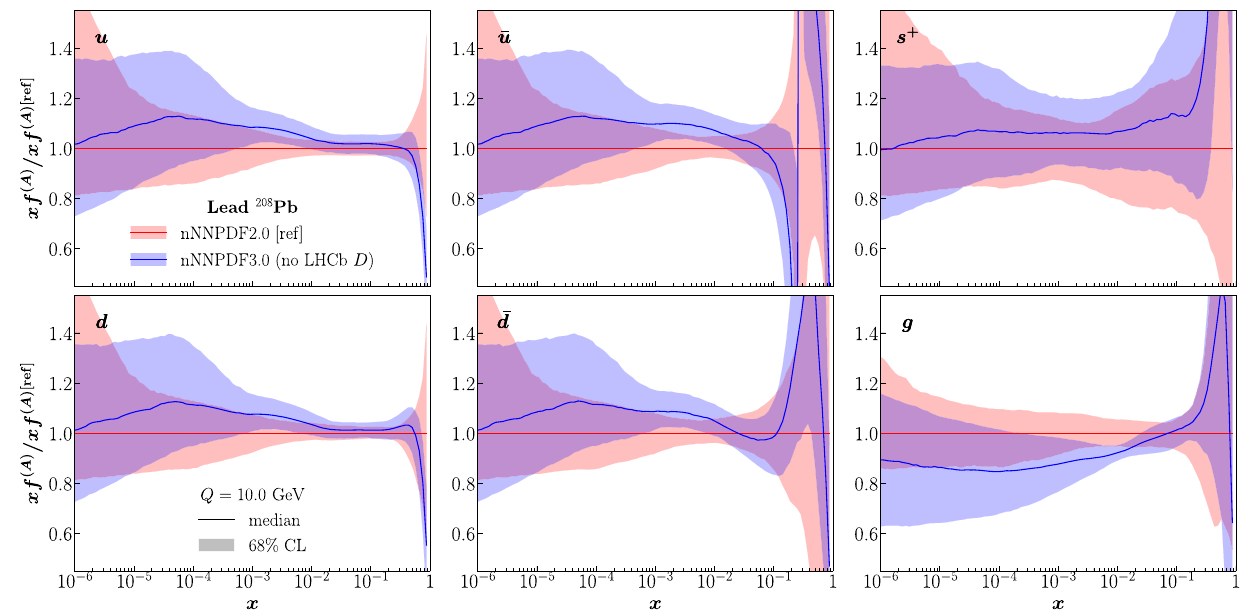
Fig. 5 Comparison between the nNNPDF2.0 and nNNPDF3.0 (no LHCb D ) fits for the lead PDFs at Q = 10 GeV, normalised to the central value of the nNNPDF2.0 reference. The uncertainty bands indicate the 68% CL intervals